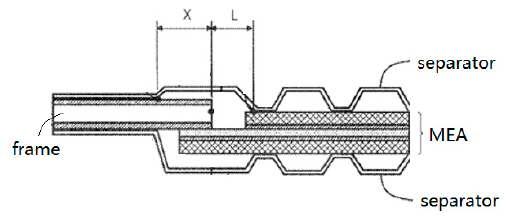
Figure 11. Unit cell structure diagram.